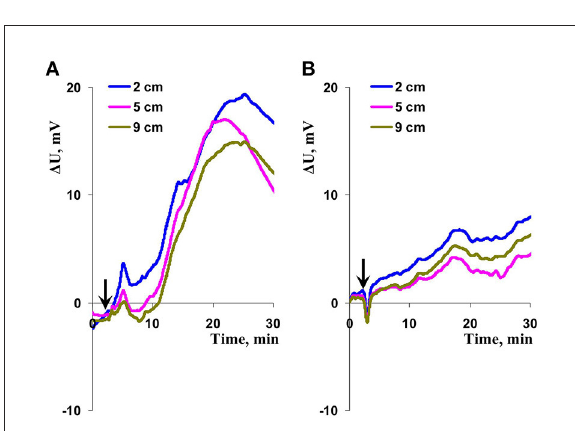
FIGURE4 Records of changes in the surface potential ( 1 U) induced by action of combination of local illumination and heating in wheat plants after 8–10 days (A) and 15–17 days (B) of absence of irrigation. The extracellular measuring electrodes contacted to the second wheat leaf on 2, 5, and 9cm from the irritated zone. Combination of the blue light (540 µ mol m − 2 s − 1 ) and heating (40 ◦ C) locally acted the top of the second wheat leaf; initiation of this action is marked by arrow.